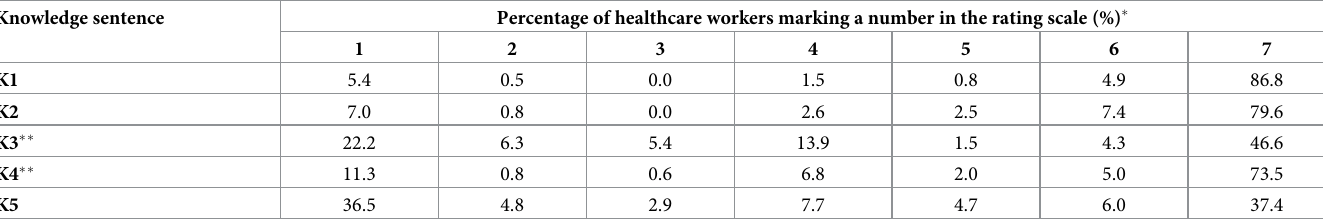
Table 2. Healthcare workers’ responses to five knowledge questions in rating scale format. Knowledge